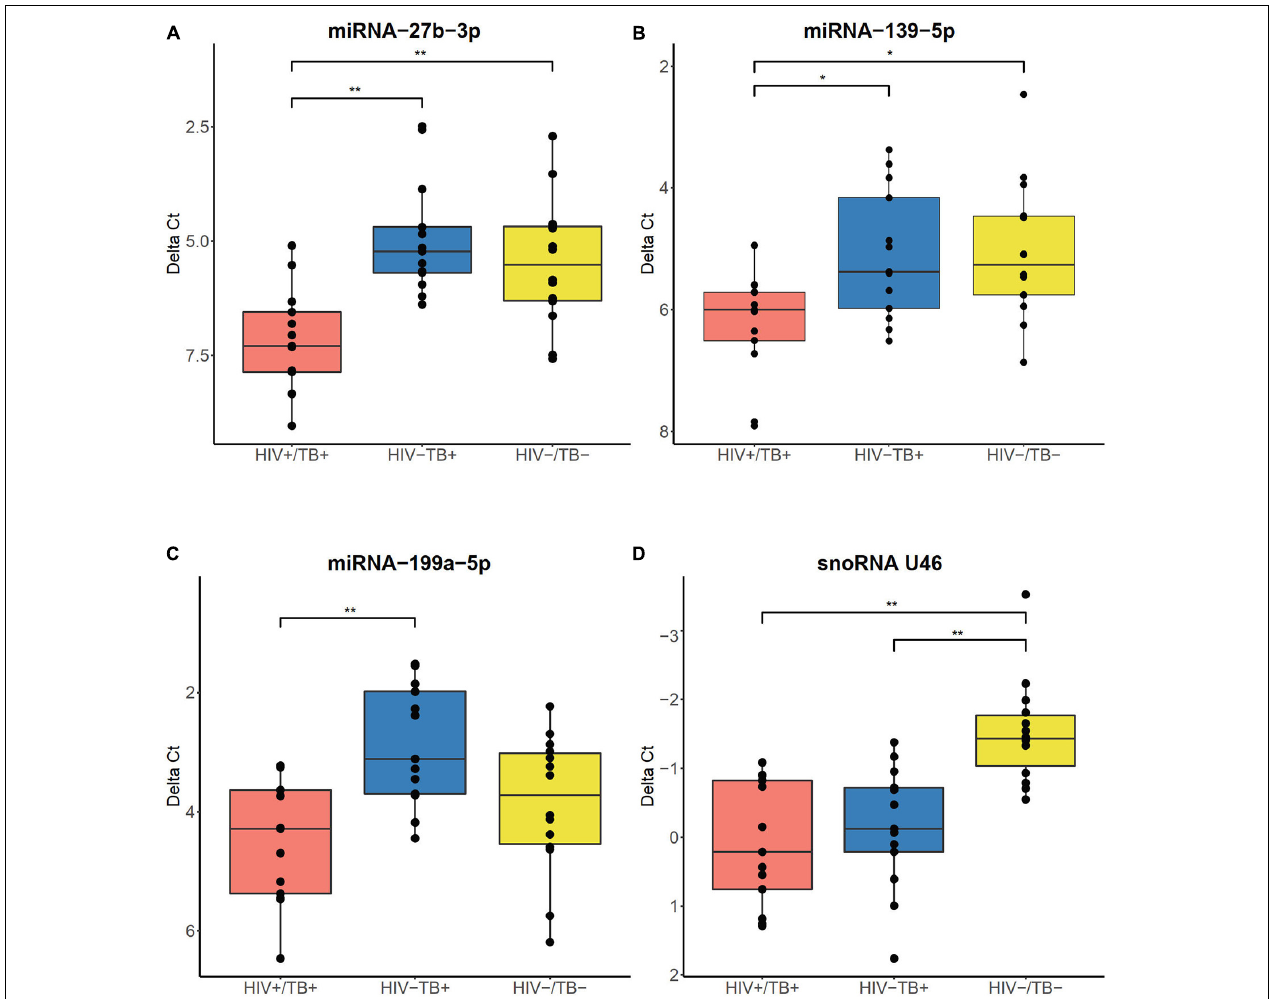
FIGURE 5 | Boxplots illustrating expression of (A) miR-27b-3p, (B) miR-139-5p, (C) miR-199a-5p, and (D) snoRNA U46, validated by RT-qPCR. Boxes show median and interquartile range, and whiskers extend to the largest values within 1.5 interquartile range from the quartile. Infection status is represented by colors, HIV+/TB+ (red), HIV-/TB+ (blue), and HIV-/TB- (yellow). Symbols on top indicate: * adjusted P < 0.05 and ** adjusted P < 0.01. P -values from the Mann–Whitney U -test with Holm-Bonferroni correction.